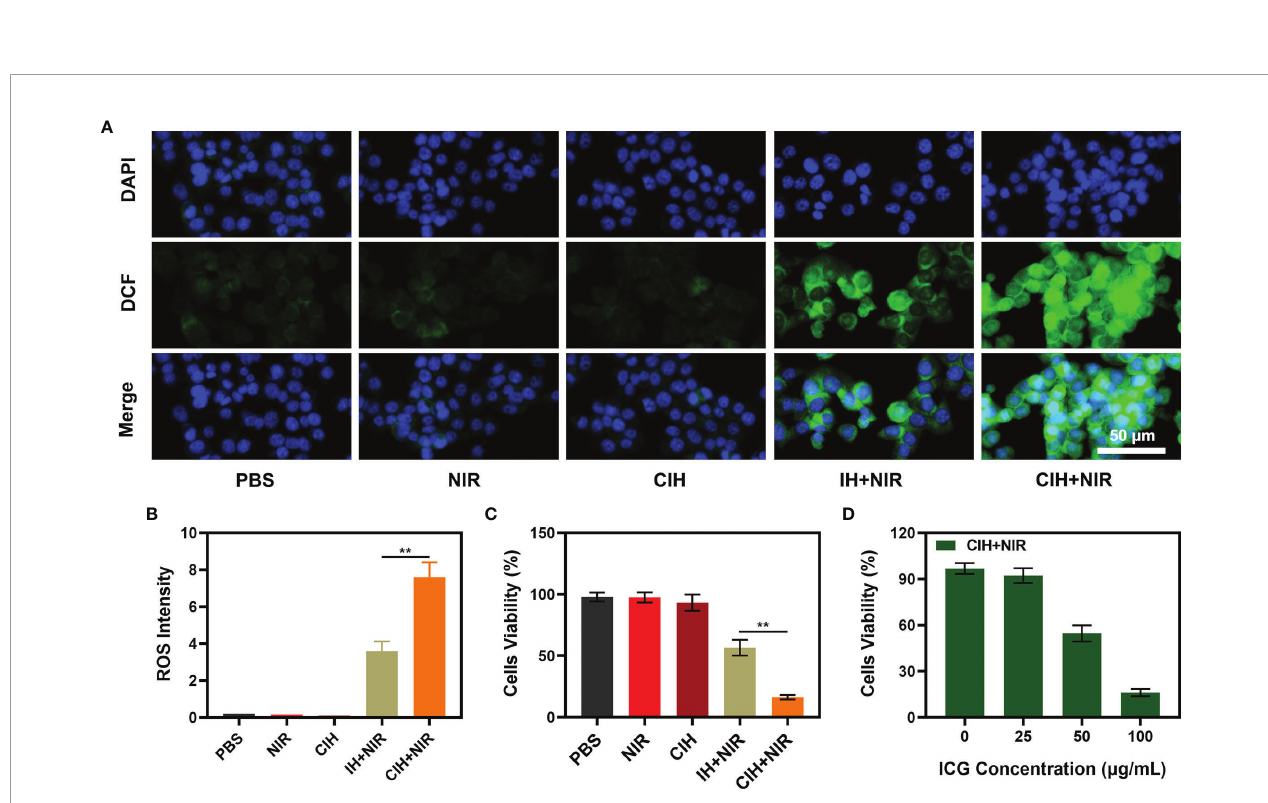
FIGURE 4 | In vitro experiments. (A) Fluorescence images of 4T1 cells stained by DCFH-DA to indicate nanoparticle-induced ROS generation. Scar bar: 50 m m. (B) Corresponding quantitative analysis of ROS generation in 4A. (C) Viability of 4T1 cells cultured in the presence of various formulations. (D) Cell viability of 4T1 cells following the CIH treatments under different ICG concentration. ** P < 0.01; Student ’ s